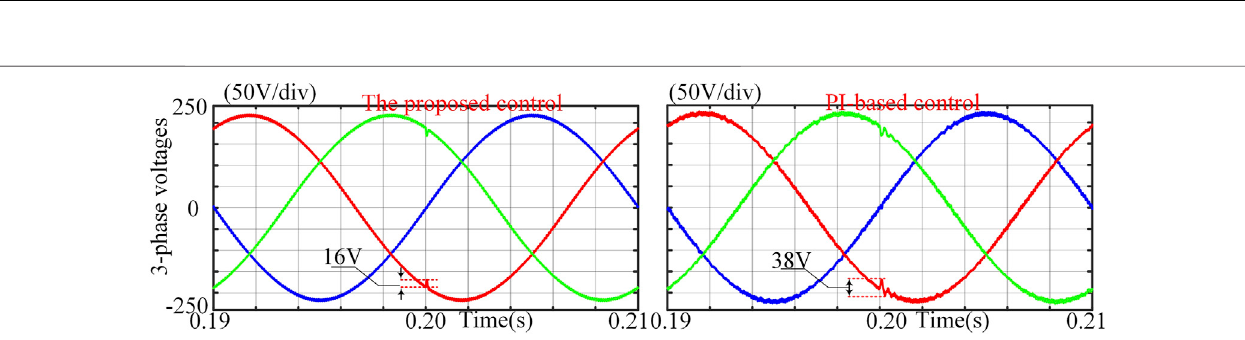
Frontiers in Energy Research |